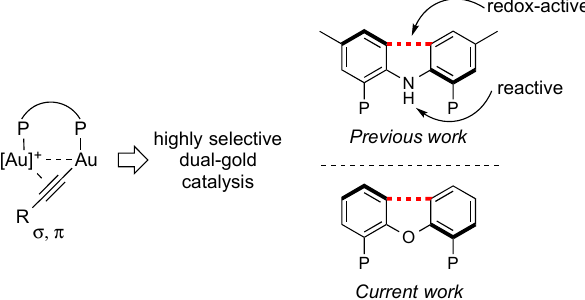
Figure 1. Left: Strategy for the preorganization of two gold-centers for σ – π -coordination of hydrocarbon π -systems using a diphosphine platform. Right: previous and current work on bis-gold chemistry with specific diphosphine ligands.